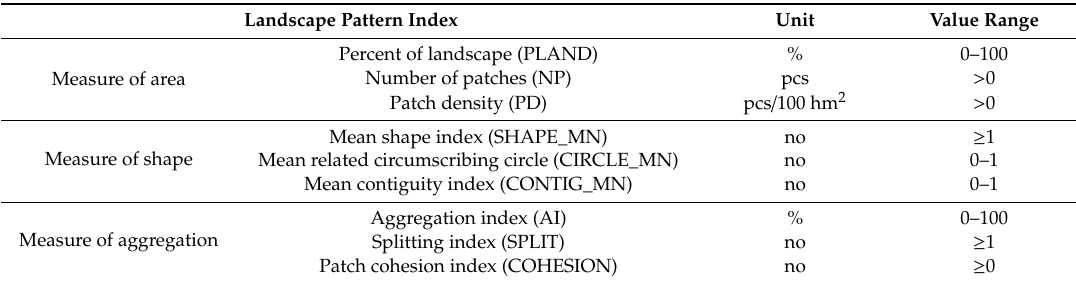
Table 3. Landscape pattern